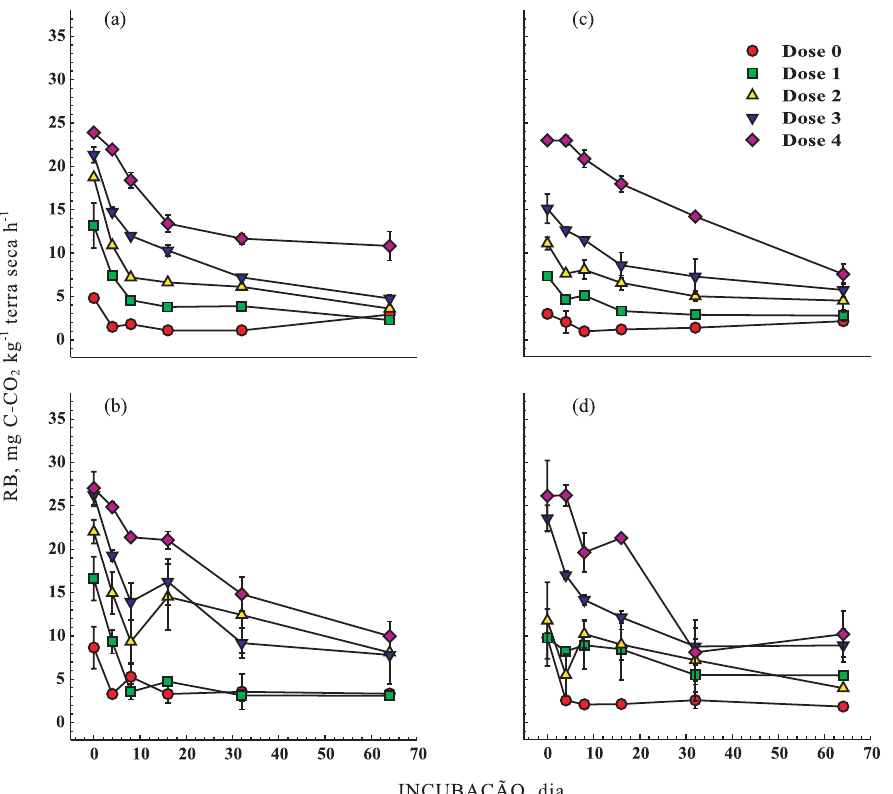
Figura 1. Variação da liberação de CO da ETE-Barueri (a, b) ou ETE-Franca (c, d). Os dados são médias de três repetições ± desvio-padrão da